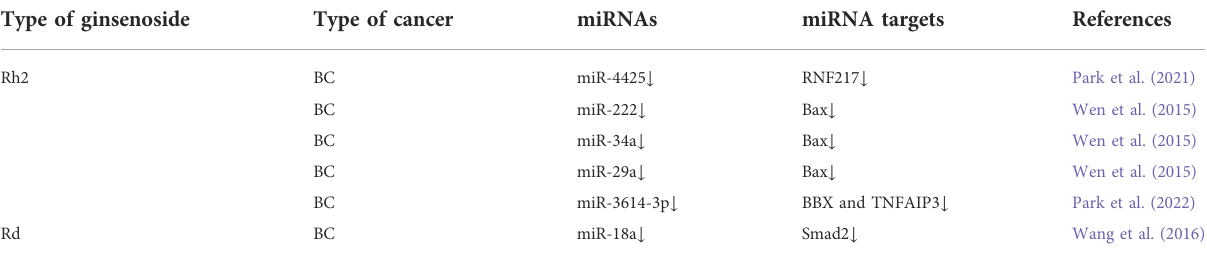
TABLE 2 Ginsenoside regulation of miRNAs in breast